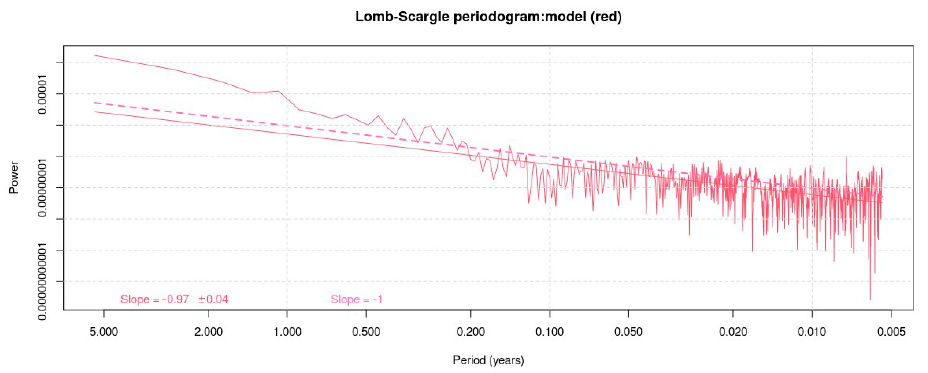
Figure 5. The Lomb–Scargle periodogram for the east component of the EPEC station; the slope of a flicker or pink noise is shown in a dashed pink line, with its value in the lower left.